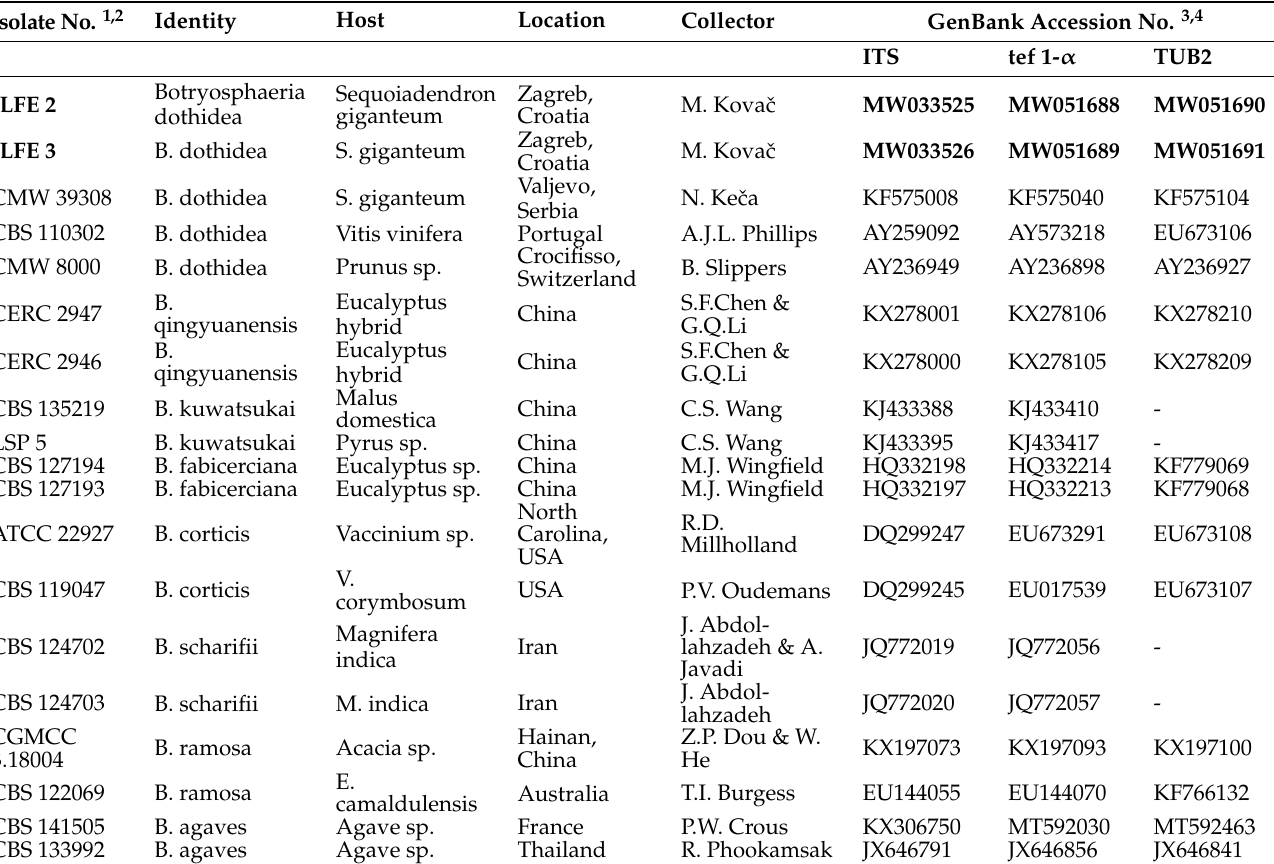
Table 1. Sequences used in the phylogenetic